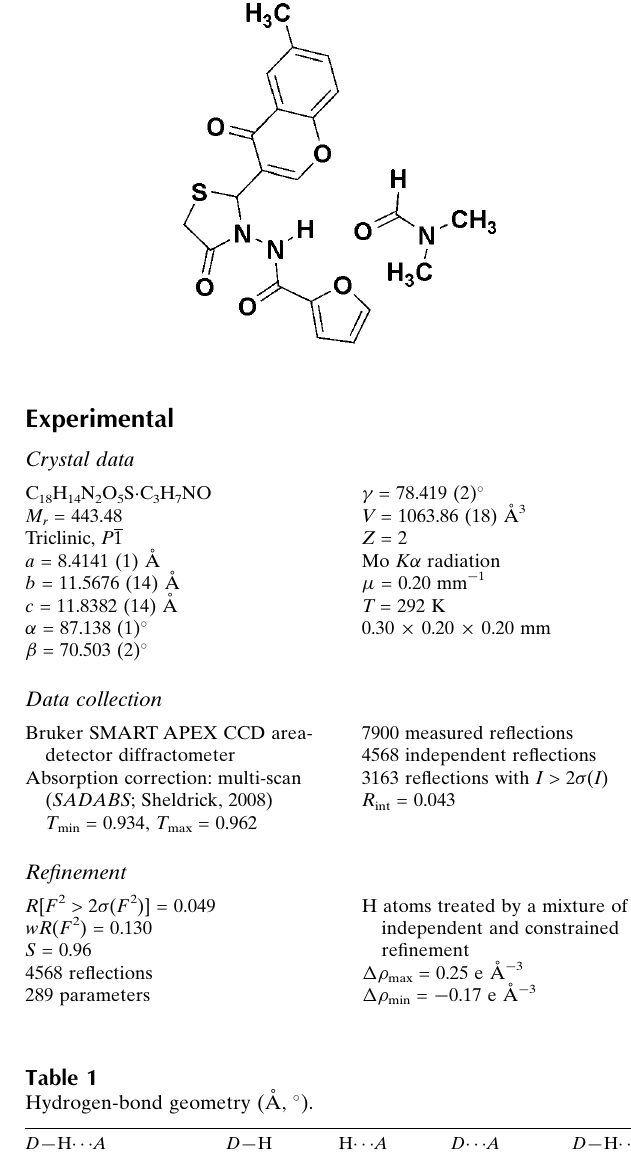
Hydrogen-bond geometry (A˚ , (cid:3)